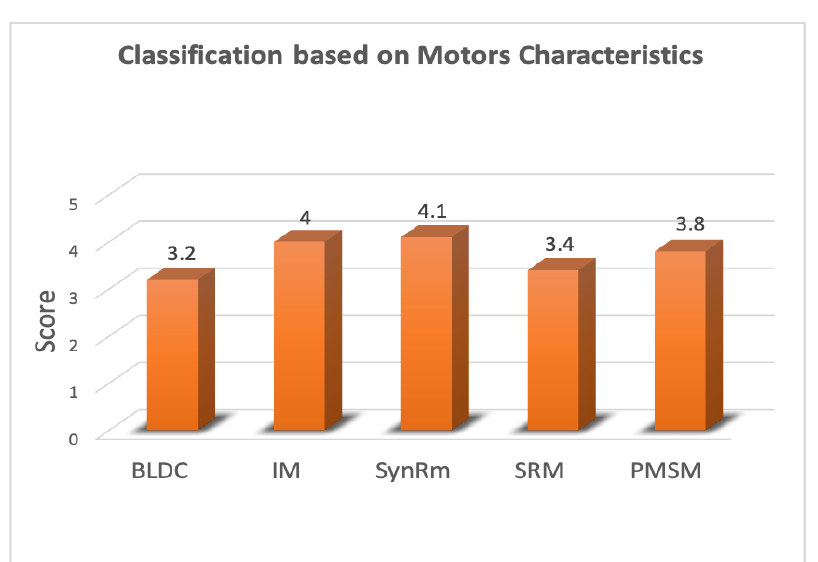
Figure 18. New classification according to the five-criteria rule for motor characteristics based on hybrid energy storage parameters.